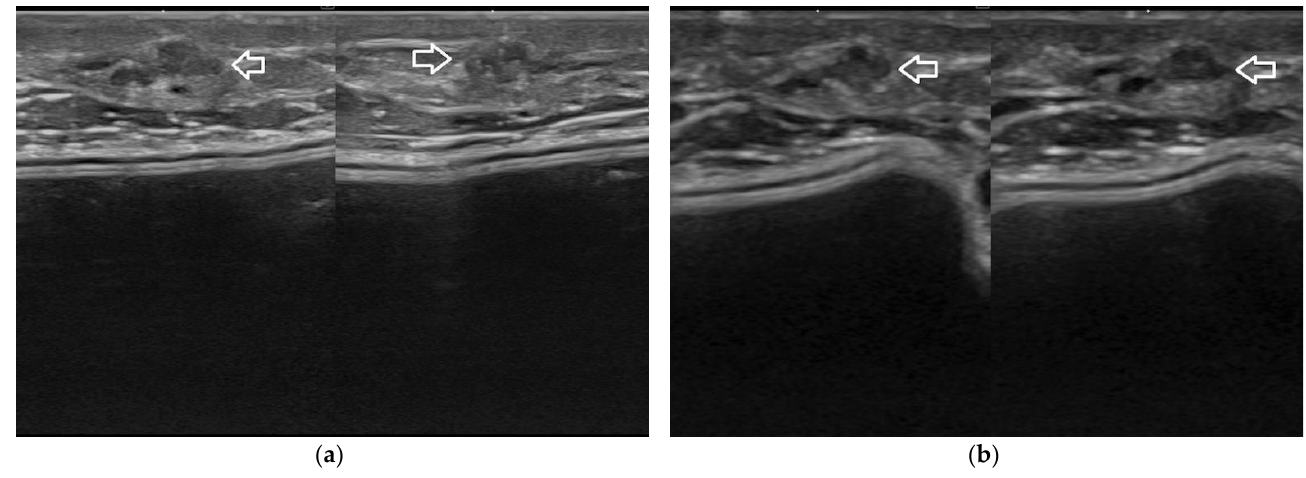
Figure 11. Local cancer recurrence in a patient with a history of subcutaneous mastectomy and subsequent breast implantation reconstruction. The tiny tumor foci are better depicted at 22 MHz ( a ) than at 15 MHz ( b , arrows).